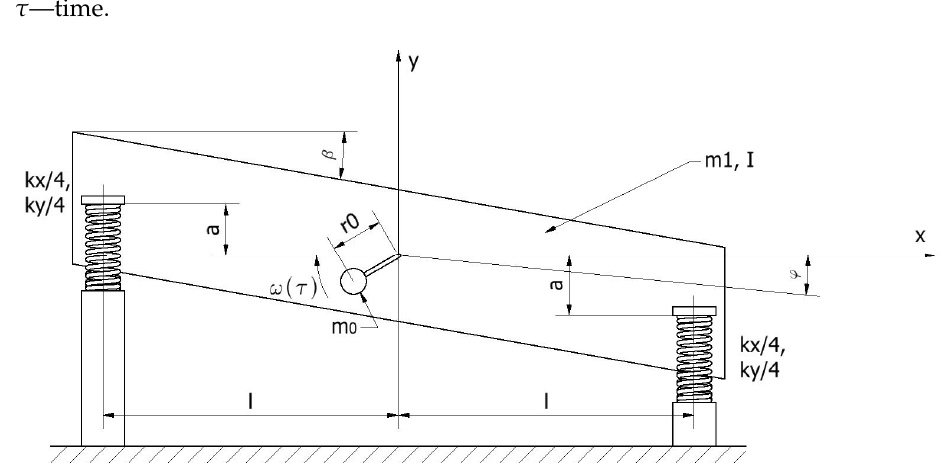
Figure 2. Plane physical model of a vibrating screen with circular vibrations.